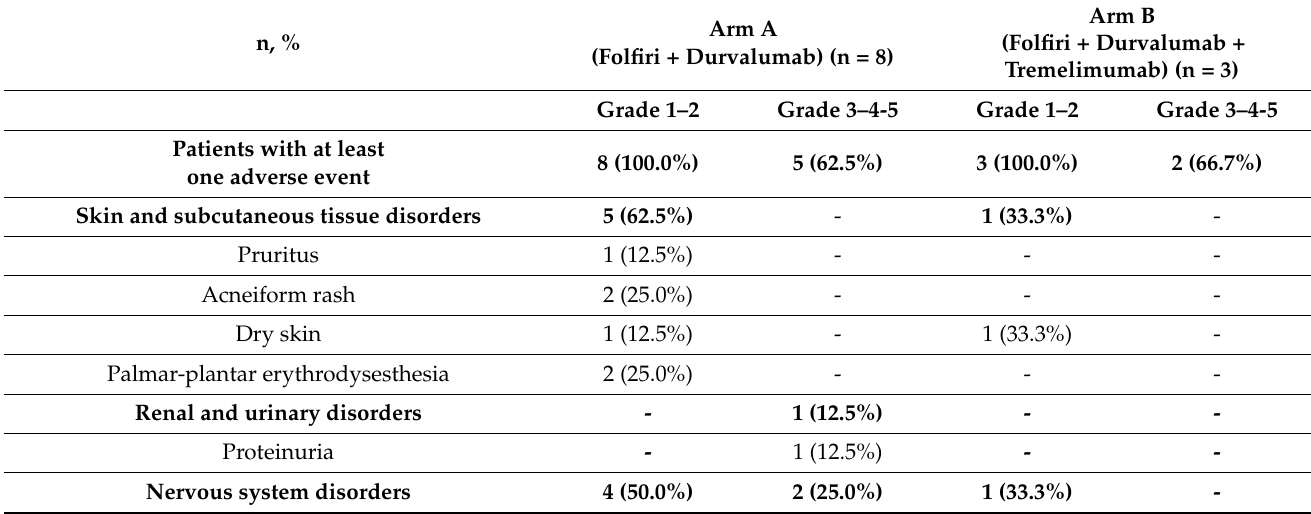
Table 2. Patient and tumour